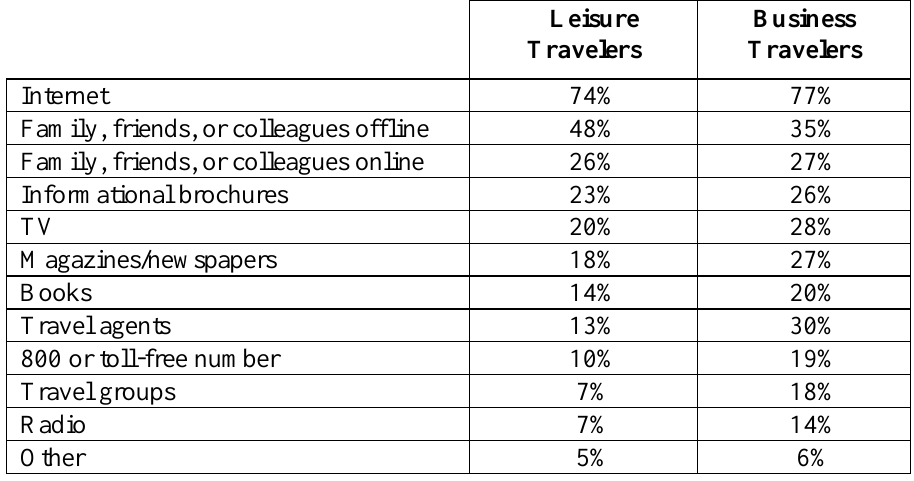
Leisure Business Travelers Travelers